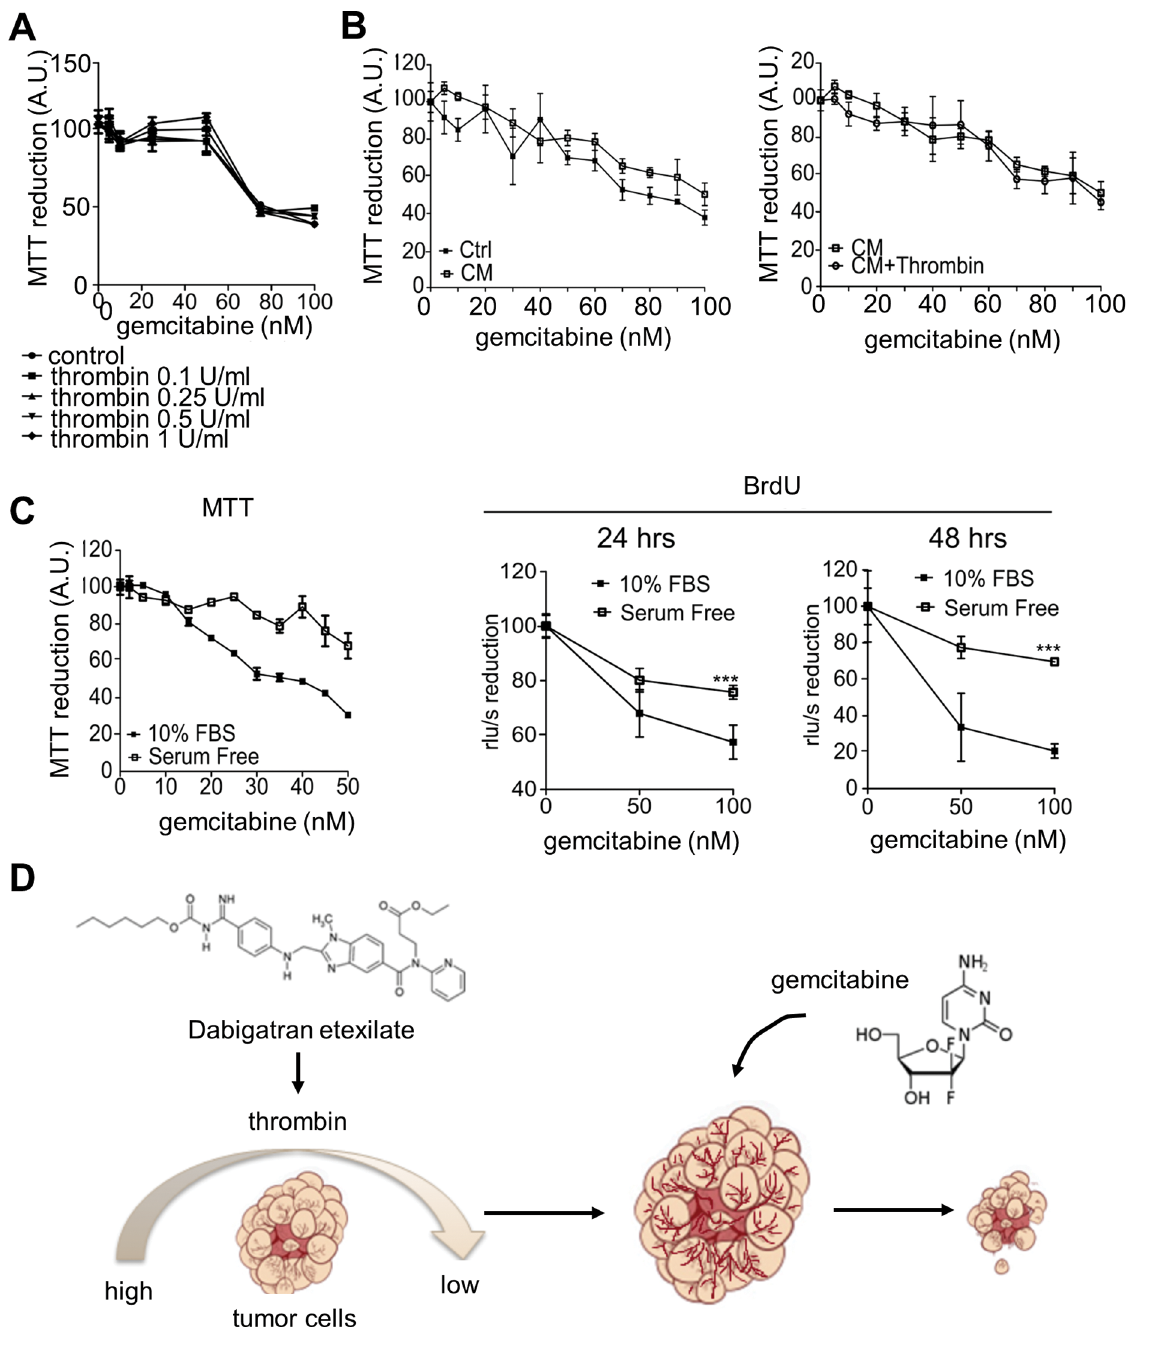
Figure 6. Gemcitabine sensitivity of Panc02 cells in vitro . (A) Effect of thrombin stimulation on gemcitabine sensitivity of Panc02 pan- creatic cancer cells. (B) Conditioned medium (CM) collected from tumor-associated fibroblasts did not affect gemcitabine efficiency (left panel), and thrombin-stimulated tumor-associated fibroblasts did not enhance gemcitabine resistance (right panel). (C) Effect of gemcitabine on cell viability (left panel) and proliferation (right panel) of Panc02 cells in the presence or absence of growth factors. Shown are the means ± SEM of three experiments performed in sixplo. (D) Proposed mechanism by which dabigatran potentiates gemcitabine-induced growth inhibition of pancreatic cancers. Dabigatran reduces thrombin production, which (1) subsequently leads to increased angiogenesis and (2) subsequently increases proliferation of tumor cells. Highly proliferative tumor cells are finally efficiently killed by gemcitabine